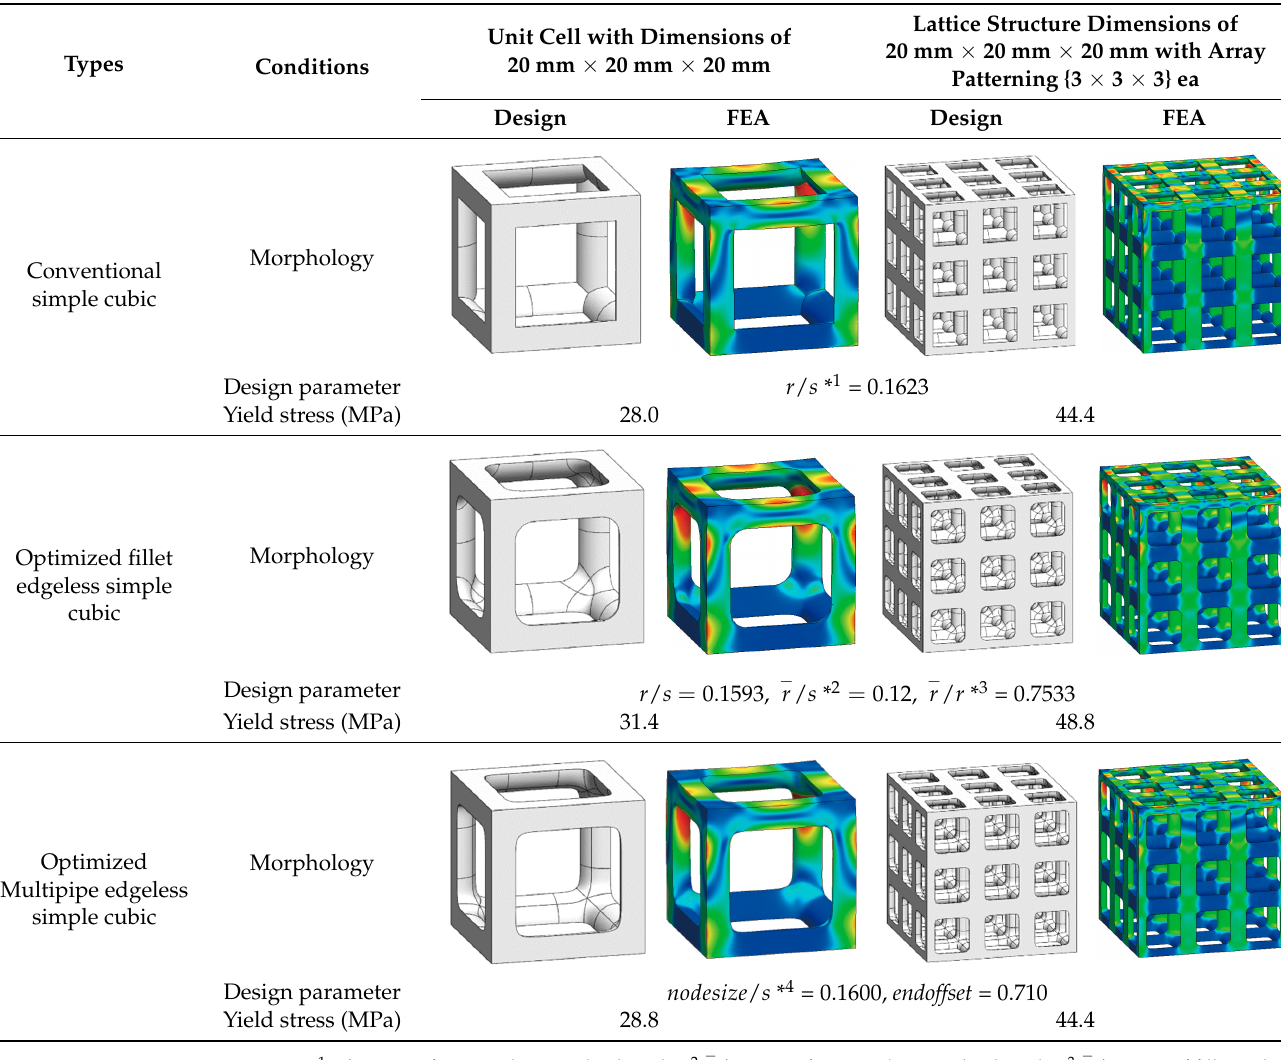
Table 4. Optimized edgeless simple cubic lattice structures with array pattering {3 × 3 × 3} ea.